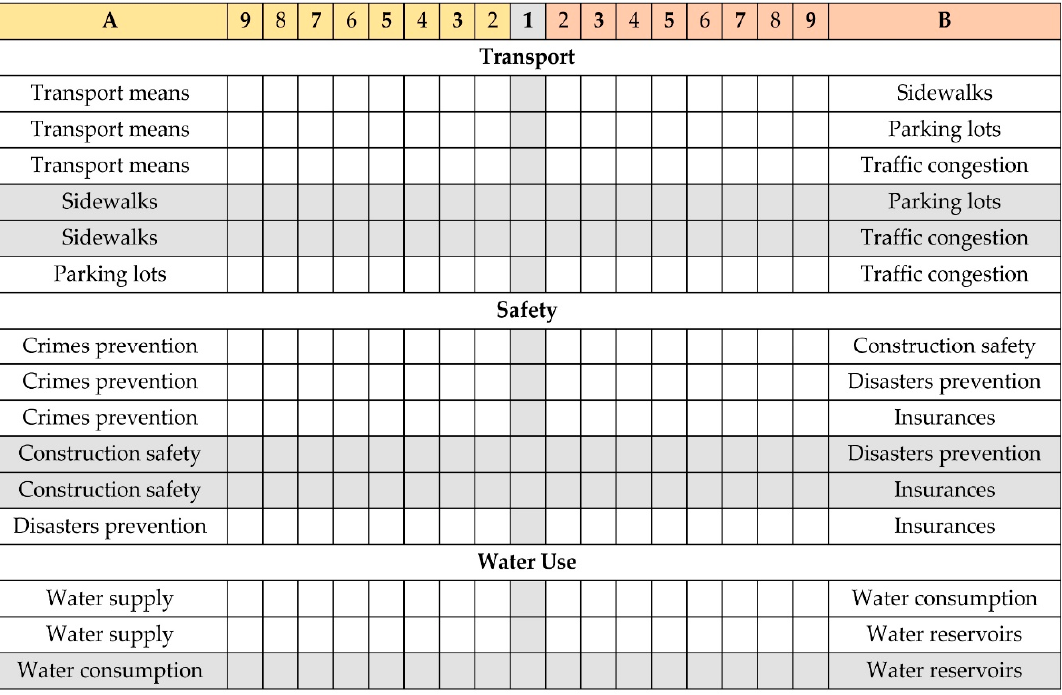
Figure A3. AHP questionnaire for prioritizing assessment indicators of Transport, Safety, and Water Use. Note: 1 = Equal importance, 3 = Moderate importance, 5 = Strong importance, 7 = Very strong importance, 9 = Extreme importance (2,4,6,8 ‐ Values in ‐ between).